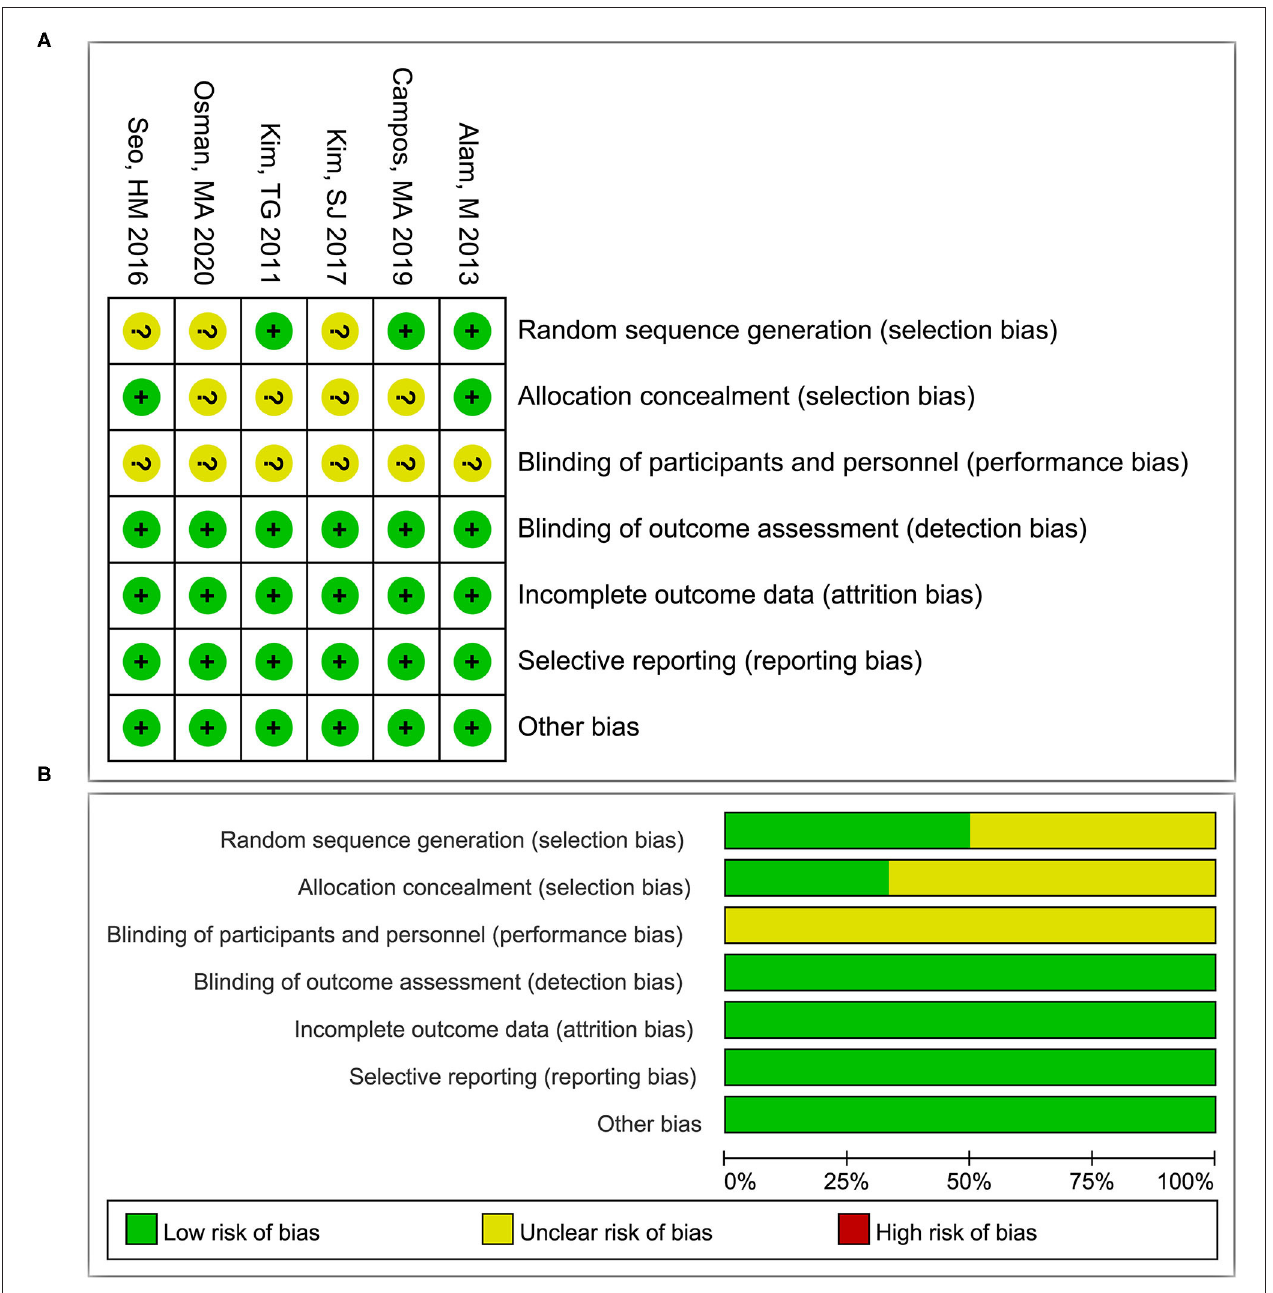
FIGURE 2 | The risk of bias assessments in each item for studies (A) and summary of the risk of bias in each item by all studies (B) . + , low risk of bias; -, high risk of bias; ?, unclear risk of